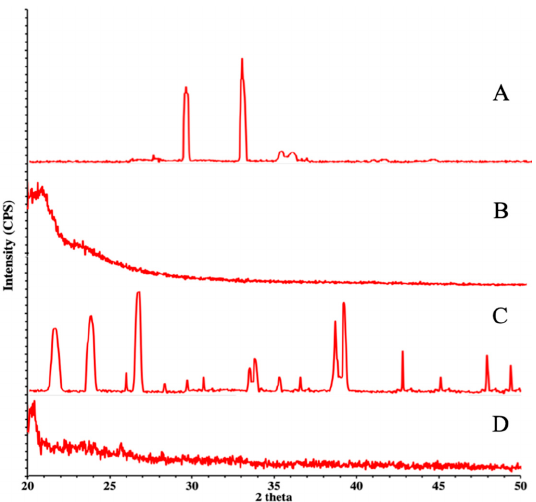
Figure 7. Illustration of XRD of PEG ( A ), PEGylated chitosan ( B ), the drug ( C ), and TAF PEGylated nanoparticles ( D ).